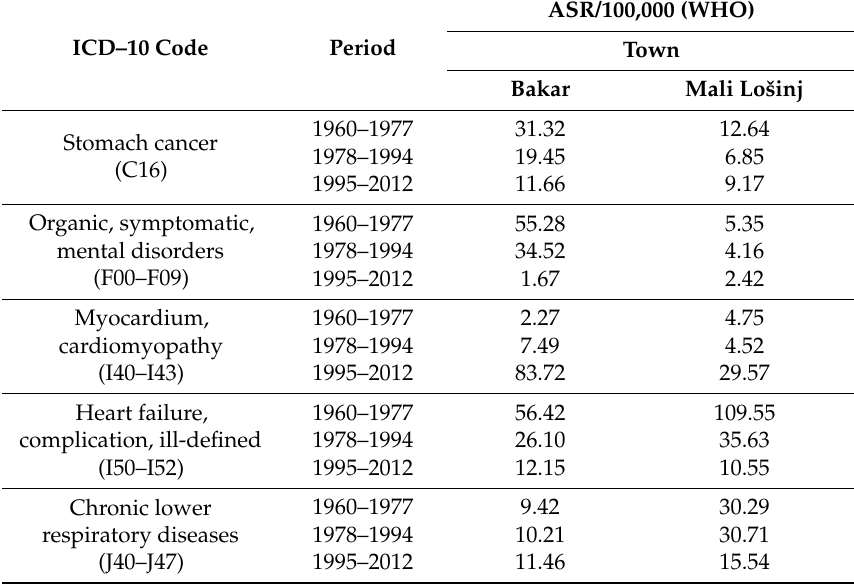
Table 6. Average age-standardised mortality rates for the towns of Bakar and Mali Lošinj according to leading causes of deaths in three studied